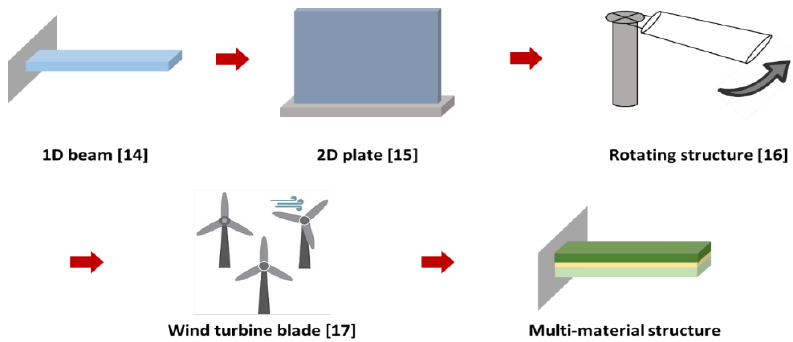
Figure 2. Research flow of the displacement–strain transformation method used in the study.